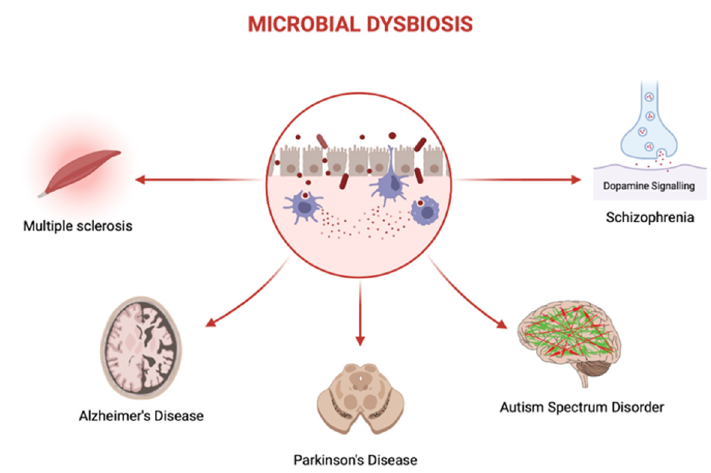
Figure 3. Neurodevelopmental and Neurodegenerative Disorders Linked with Dysbiosis. Microbial dysbiosis is defined as an imbalance of microbiota where there is a relative increase in pathogenic bacteria compared to beneficial ones. Microbial dysbiosis has been linked to several neurodevelopmental and neurodegenerative disorders including multiple sclerosis, Alzheimer’s disease, Parkinson’s disease, autism spectrum disorder, and schizophrenia. However, the underly- ing mechanisms explaining the effects of microbial dysbiosis on these disorders remain unclear (Adapted from “Dysbiosis”, by Biorender.com (accessed on 16 October 2022). Retrieved from https://app.biorender.com/biorender-templates (accessed on 16 October 2022). It is theorized that proteins involved in NDs, such as A β and alpha-synuclein, can aggregate and spread throughout the brain in a prion-like manner (i.e., neuron-to-neuron propagation) [228,229]. However, there is continuous debate regarding the site of origin